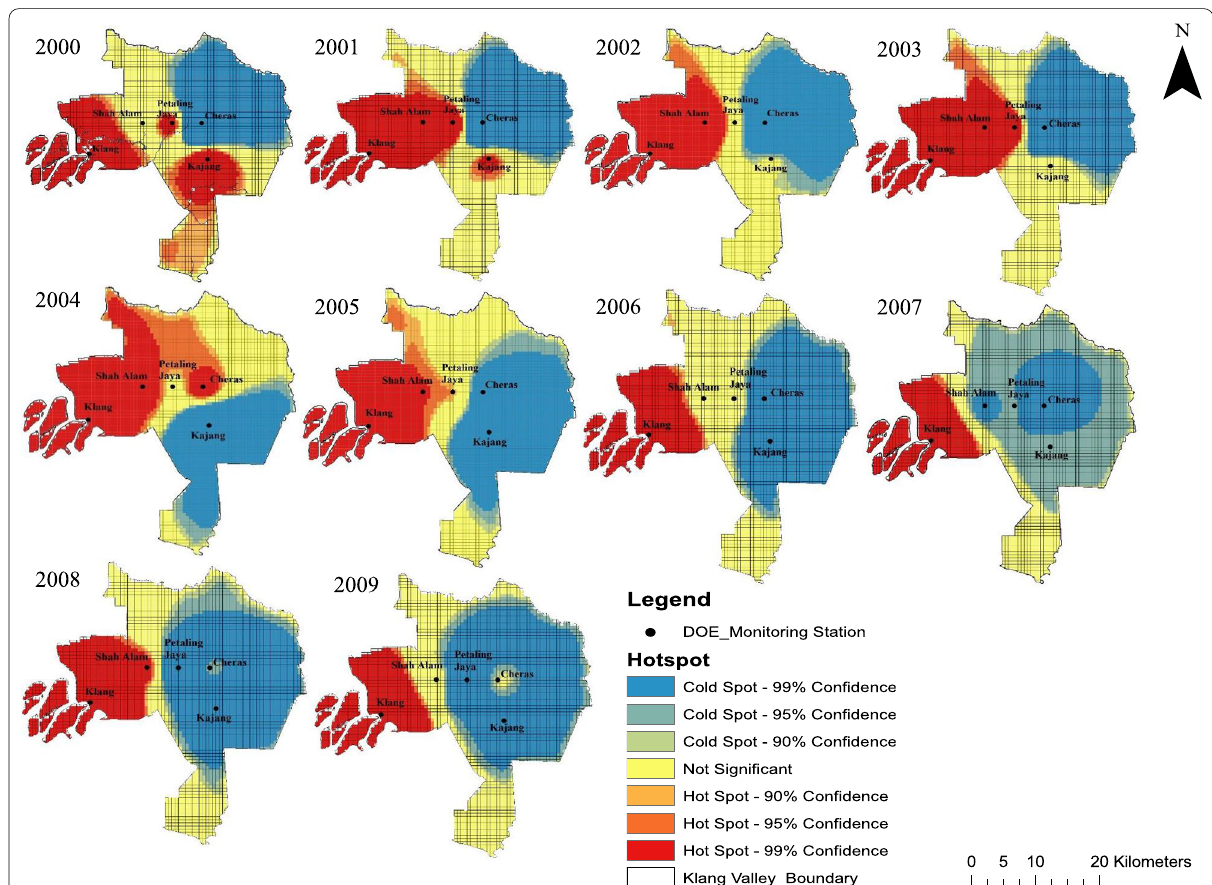
Fig. 3 Hot spot areas with high PM 10 concentrations and cold spot areas with low PM 10 concentrations (µg/m 3 ) at five DOE monitoring stations in the Klang Valley: Klang, Shah Alam, Petaling Jaya, Cheras and Kajang stations from 2000 to